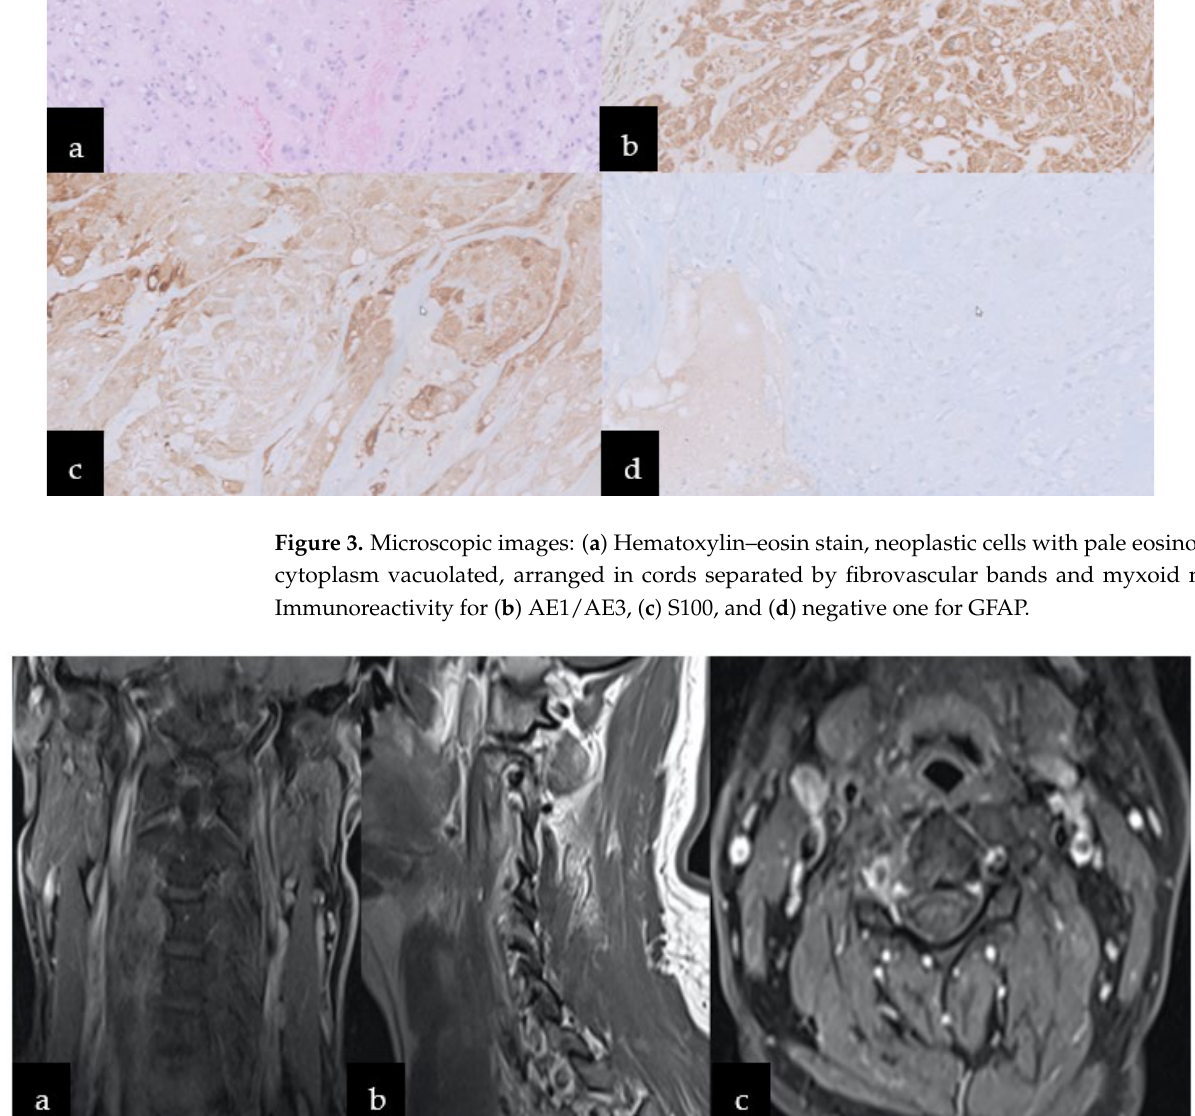
Figure 4. Follow-up MRI after 12 months showing no signs of recurrence on T-weighted 1 sequence with contrast in the following planes ( a ) coronal, ( b ) sagittal, and ( c ) axial.